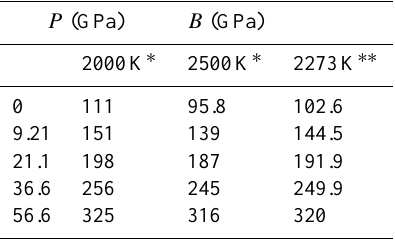
∗ from Table 6 of Sushil (2005); ∗∗ from interpolation to